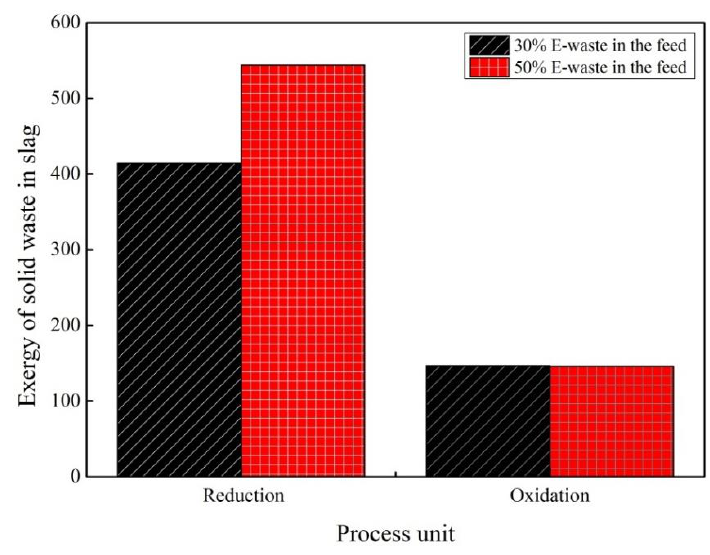
Figure 11. Effect of solid waste in slag on chemical e xergy for two scenarios.